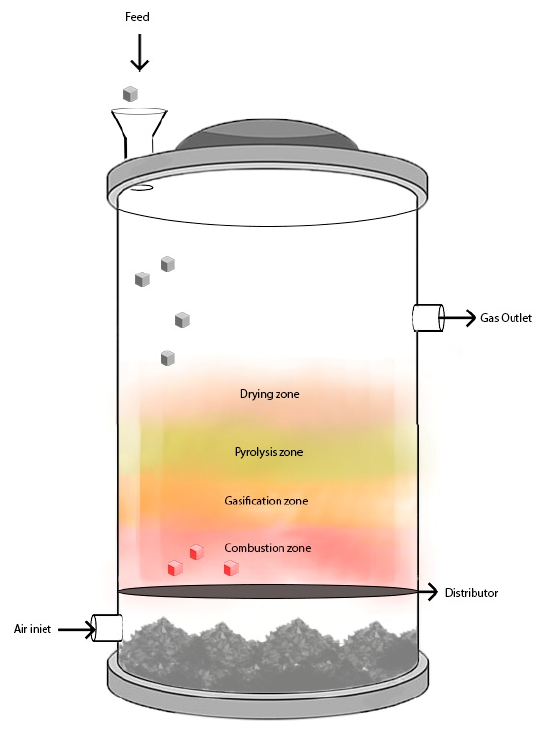
Figure 1. Updraft or counter current gasifier.